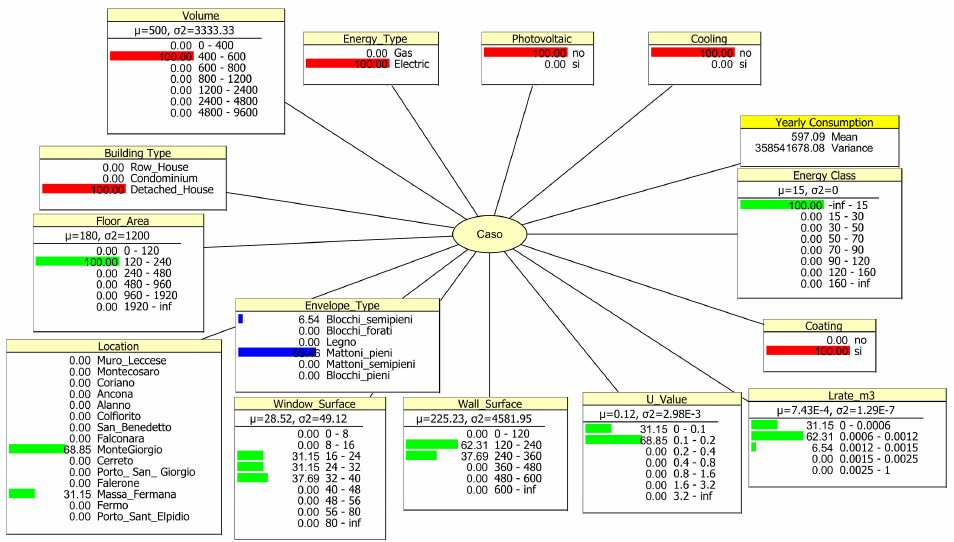
Figure 24. A second scenario